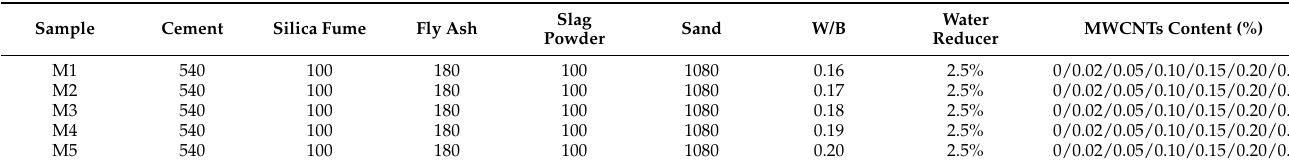
Table 2. Mix proportions of the specimens (kg/m 3 ).